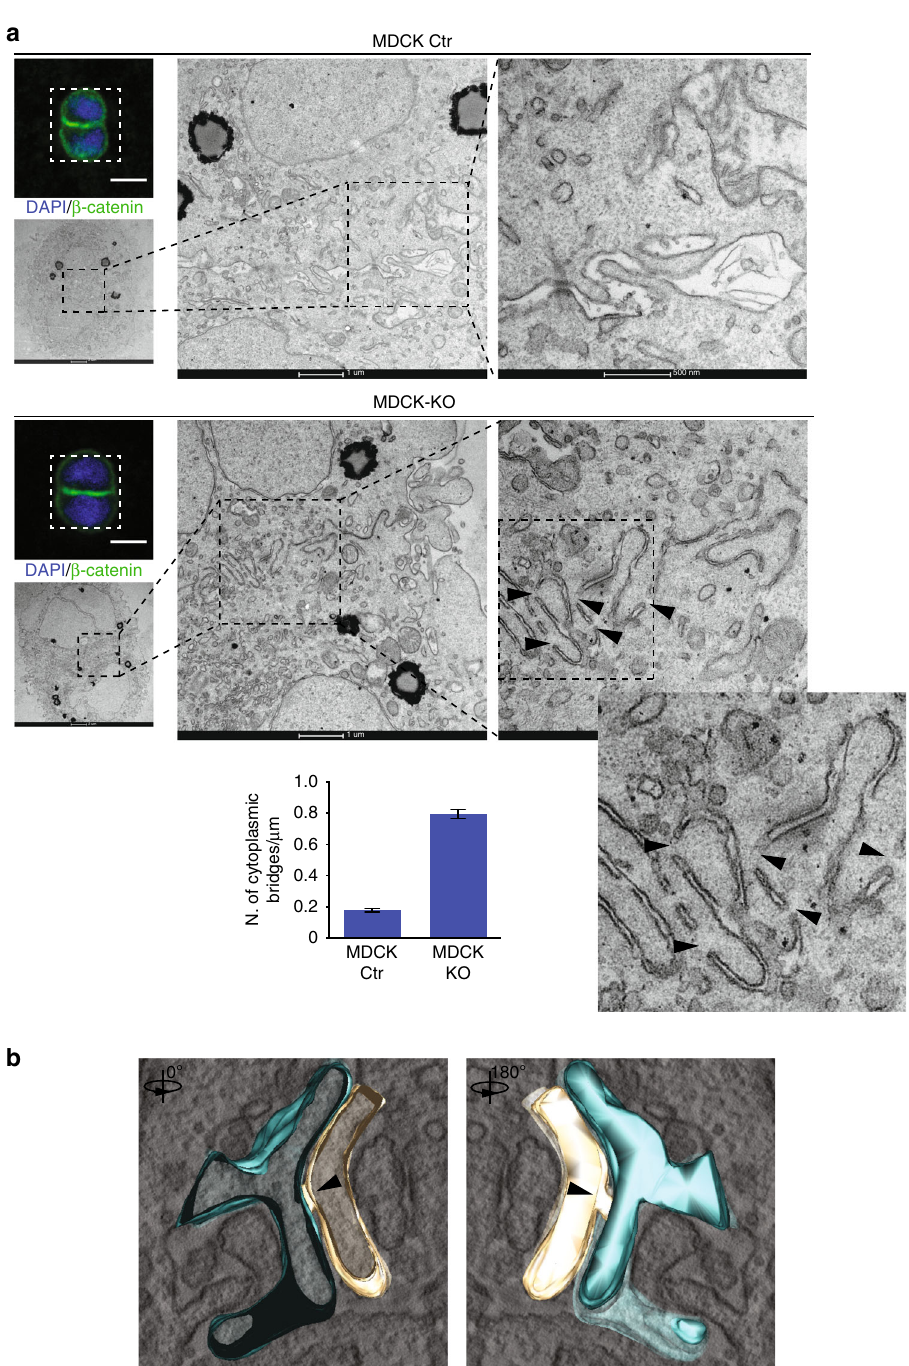
Fig. 7 Loss of IRSp53 alters the opposing plasma membranes at the nascent AMIS. a MDCK Ctr (top) and IRSp53-KO cells (middle) were seeded as single cells on Matrigel-coated gridded coverslips. The cysts were fi xed 16 h after seeding, stained with anti-ß-catenin (green) and DAPI (blue). Two-cell stage cysts were initially identi fi ed on grids by confocal microscopy. Scale bar, 10 µ m. Samples were then processed for electron microscopy, with images of the corresponding cells shown at the indicated magni fi cations. Arrowheads, inter-cytoplasmic bridges of the plasma membranes along the AMIS. Bottom: Quanti fi cation of the inter-cytoplasmic bridges/ µ m. Two-cell stage cysts were analysed from n = 2 independent experiments. In all, n = 484 (Ctr) and n = 332 (KO) different fi elds from n = 6 (Ctr; KO) samples were counted from serial sections along the Z-axis. Data are means ± s.e.m. P value, student ’ s t-test two-tailed. *** p < 0.001. Source data are provided as a Source Data fi le. b Images of a three-dimensional tomographic reconstruction of an inter-cytoplasmic bridge at the opposing membranes of MDCK IRSp53 -KO cells during early cystogenesis (see also Supplementary Movie 4). Arrowheads, inter-cytoplasmic